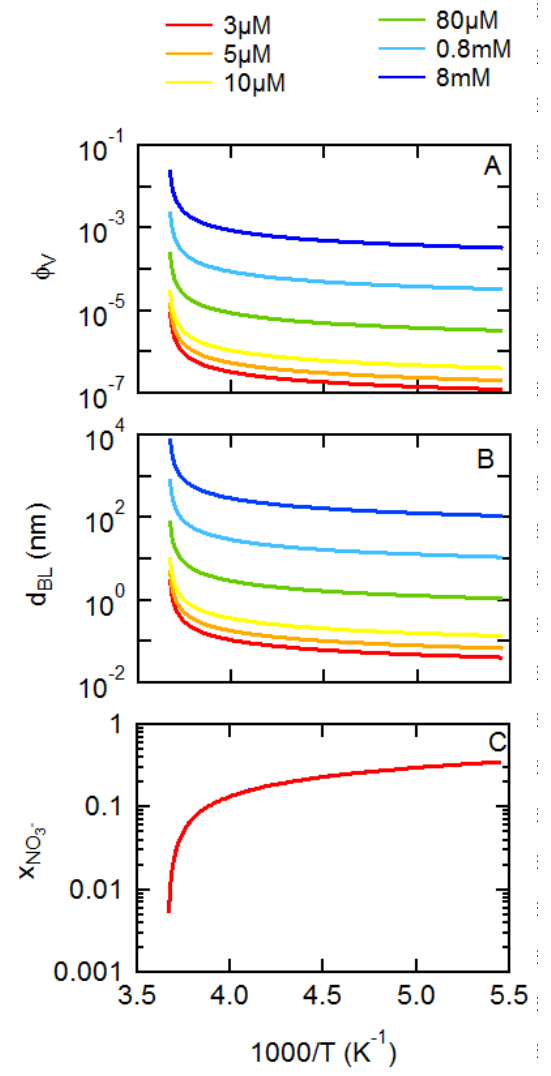
535 Fig. 3. Model prediction based on non-volatile solute scenario of (A) brine volume fraction, (B) brine thickness calculated assuming spherical ice crystals, 1mm in radius, and (C) nitrate mole fraction in the brine at different nitrate concentrations in the melt and at a range of temperatures using the full model which accounts for non- ideal